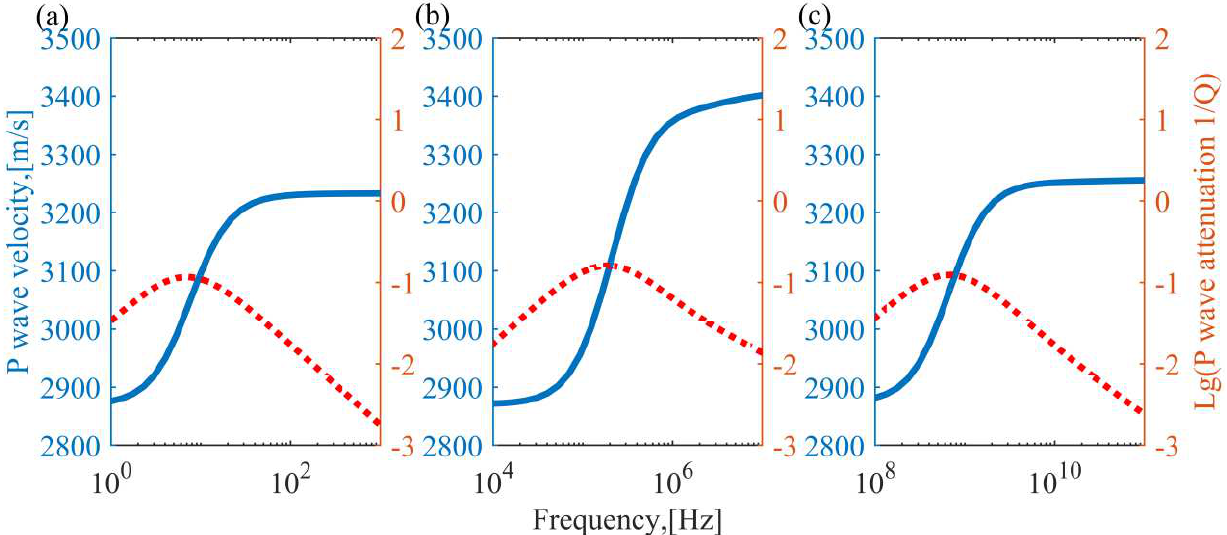
Figure 2. Comparison of velocity dispersion and attenuation calculated by three rock physics models. ( a ) Pore fluid dissolution model, ( b ) Squirt model and ( c ) Pride model. The blue solid line is the P wave velocity, and the red dash line is attenuation.